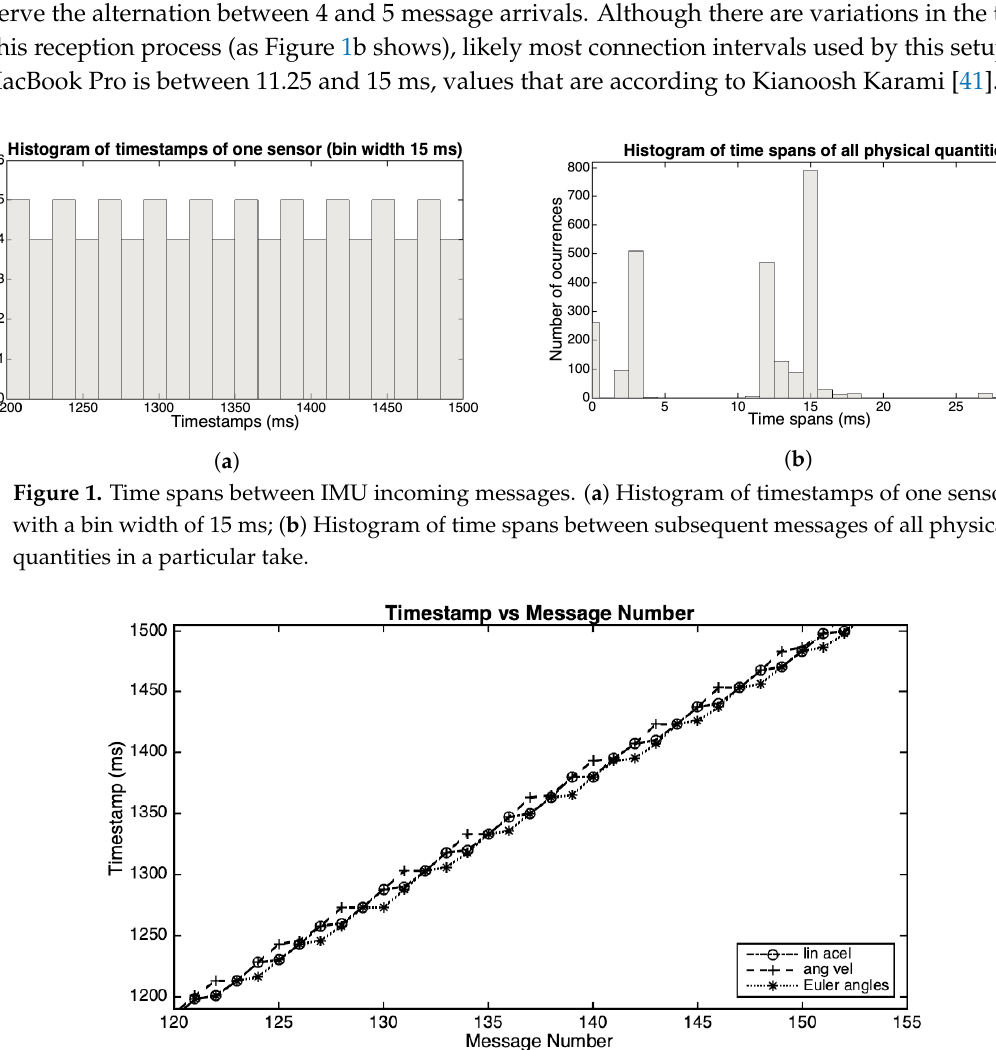
Figure 2. Plot of timestamp vs. message number for each physical